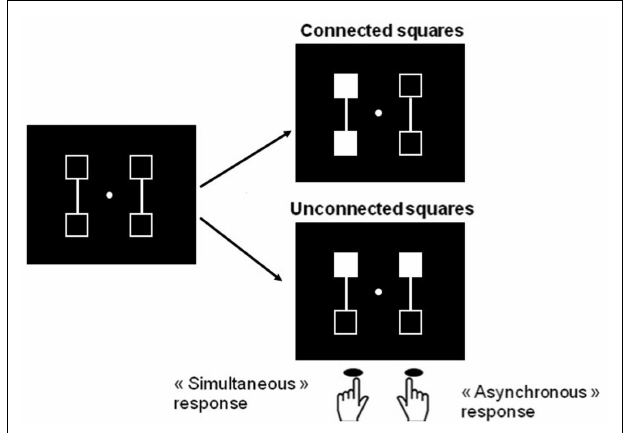
FIGURE 4 | Illustration of the procedure designed to compare simultaneity/asynchrony discrimination for connected and unconnected squares, and squares displayed in the same hemifield vs. in different hemifields .Two squares are filled in, in gray, either simultaneously or asynchronously.These two squares are either connected or not. Participants are instructed to respond with the right key when they think the squares are filled in asynchronously and the left key when they think filling-in occurs simultaneously. In the examples, filled squares are connected and located within the same hemifield in the right top figure, and unconnected and in different hemifields in the right lower figures.The intra- vs. inter-hemifield manipulation has been conducted without connecters in a first experiment (Lalanne et al., 2012b), and with connecters in a second, distinct experiment (Lalanne et al., 2012c).The examples correspond to the second experiment. In this experiment, the location of the connecters (vertical vs. horizontal), and the location of the targets (within the same vs. in different hemifields) yielded four main possibilities (targets connected within the same or different hemifields, and targets unconnected within the same or different hemifields), which were equally represented and displayed in random order.